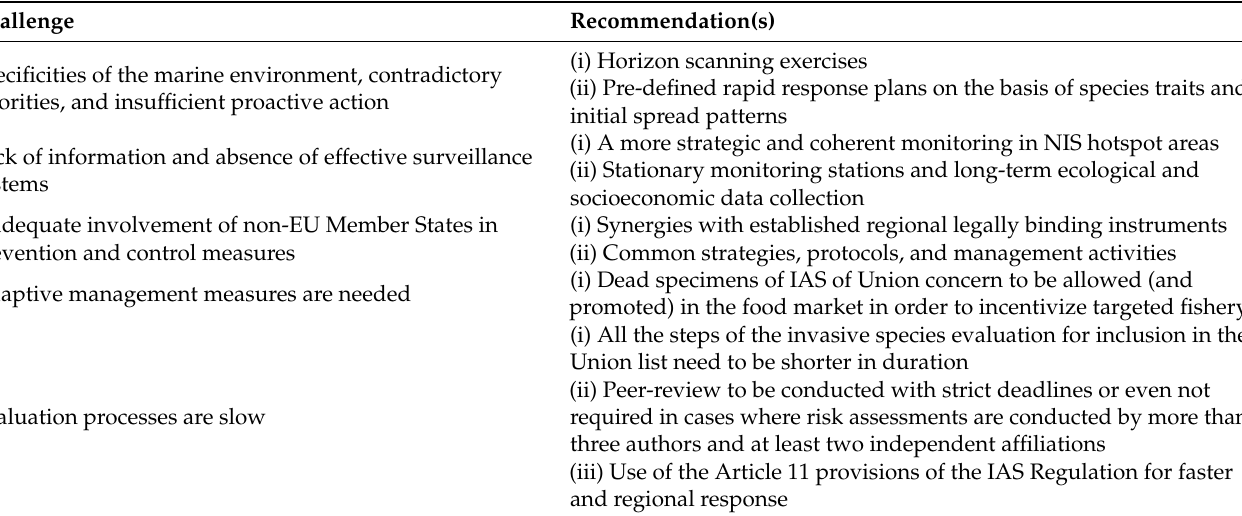
Table 1. Overview of challenges identified from the lionfish invasion in the Mediterranean and recommendations to improve EU Regulation and implementation against marine invasive alien species